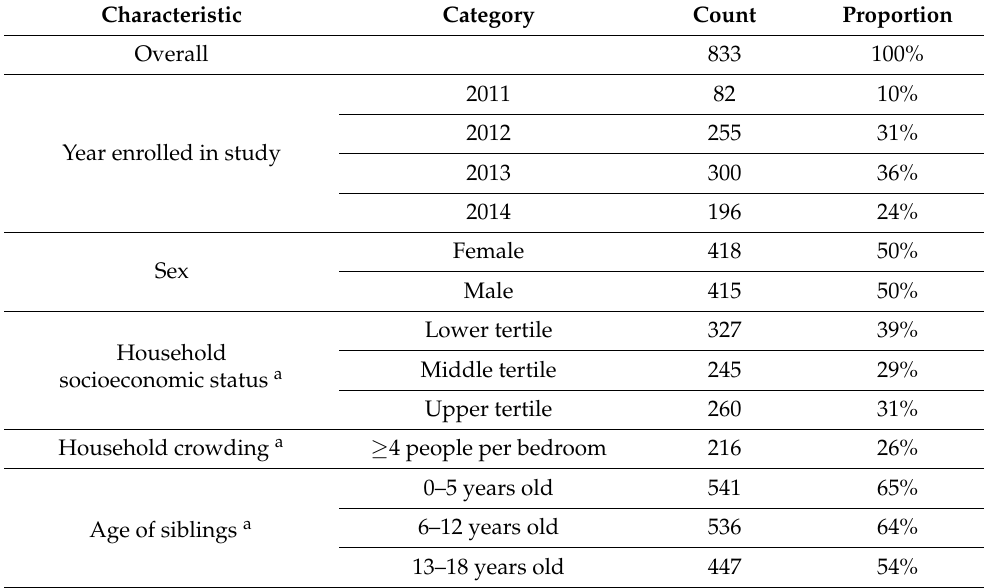
Table 1. Characteristics of study participants in Managua,